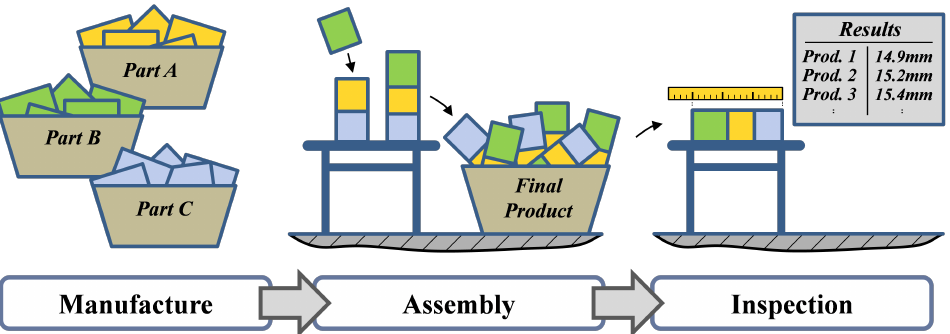
Figure 4. Virtual reproduction of the manufacturing, assembly and inspection of each part by statistical tolerance analysis using Monte Carlo simulation.